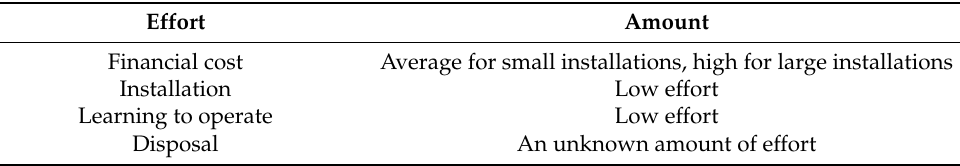
Table 3. Investors’ effort in a PV micro-installation ( n =